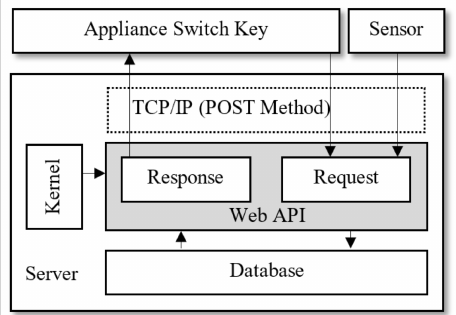
Figure 5. The Web